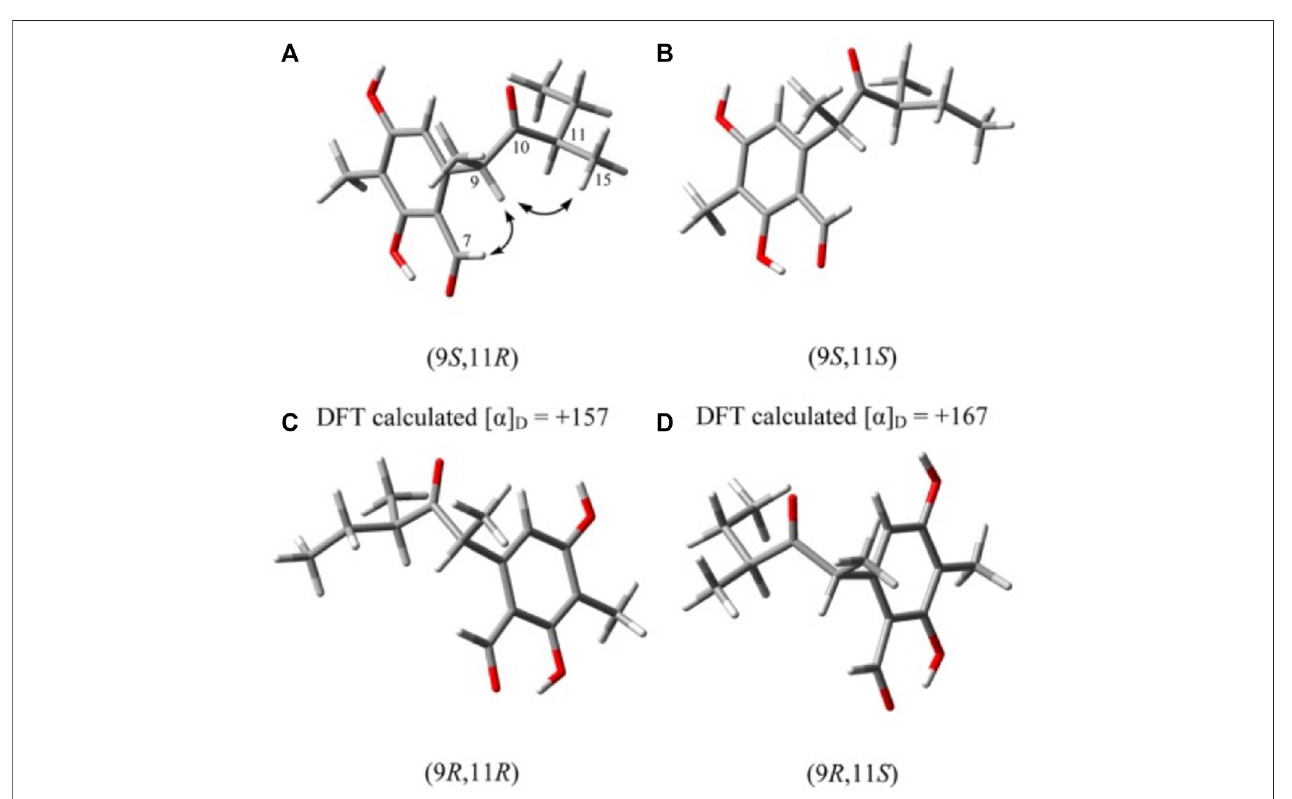
FIGURE 3 | Global minimum energy structures of the four possible diastereoisomers of compound 1.